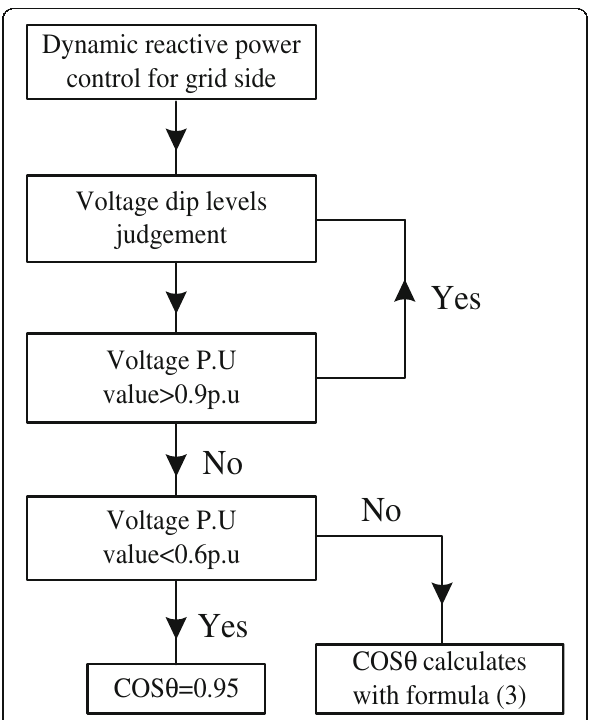
Fig. 2 Reactive power control strategy for grid